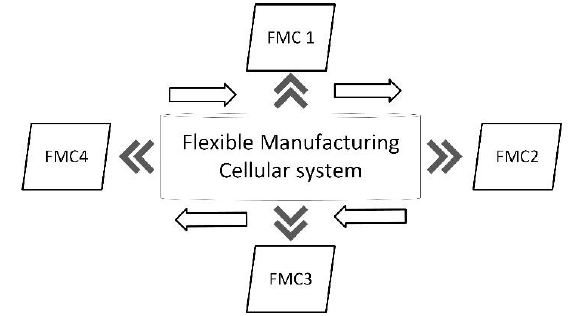
Fig. 2: Flexible Manufacturing Cellular layout for multiple